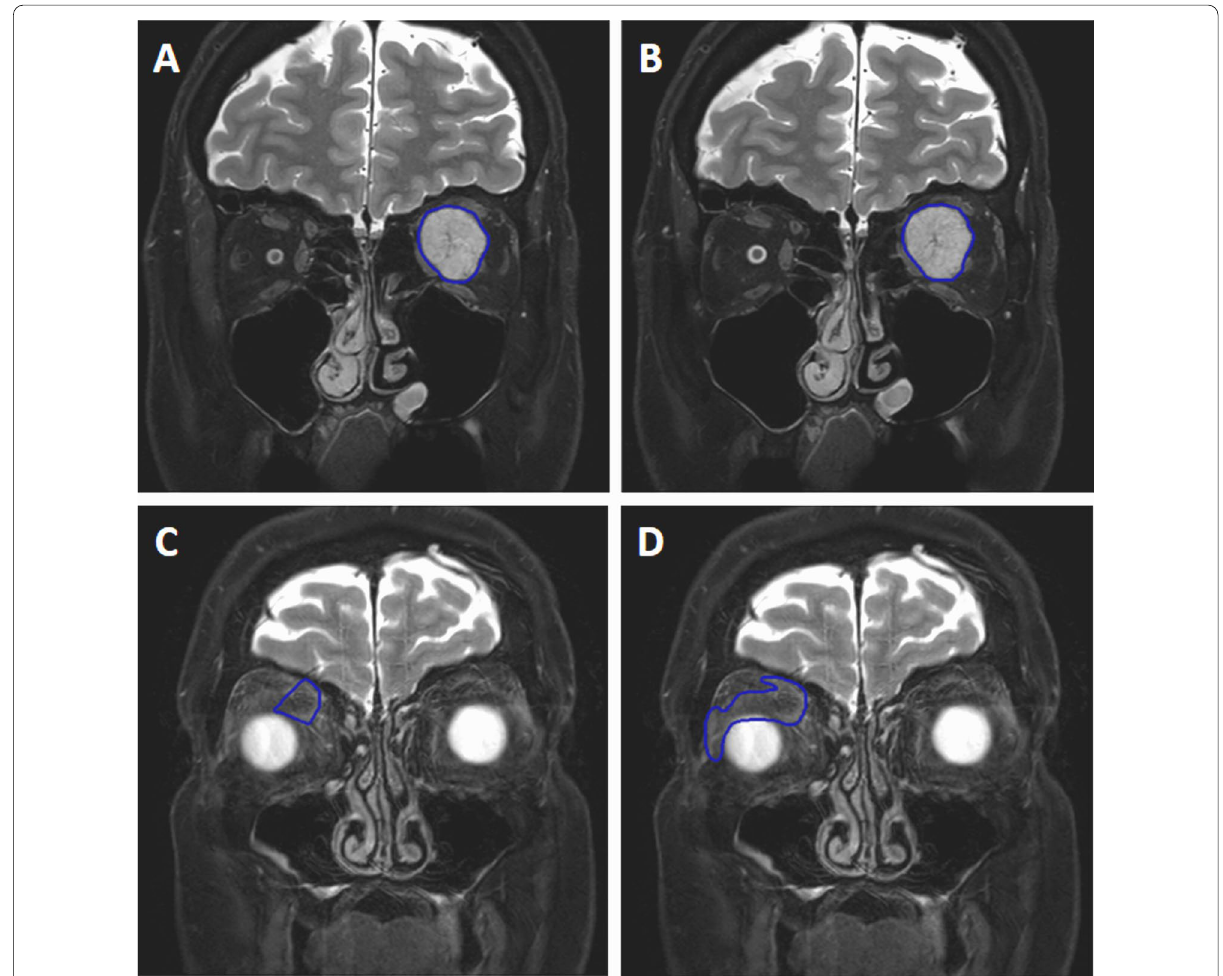
Fig. 3 Example of good versus poor reproducibility between observers based on lesion definition: Fat‑suppressed coronal T2W images through the orbits in a patient with orbital lymphoma ( A , B ) and in a patient with right idiopathic orbital inflammation ( C , D ). The reproducibility between the 2 observer segmentations in ( A , B ) is excellent (Dice similarity coefficient 0.97), whereas it is poor in the observer segmentations in ( C , D ) where the lesion is poorly defined (Dice similarity coefficient